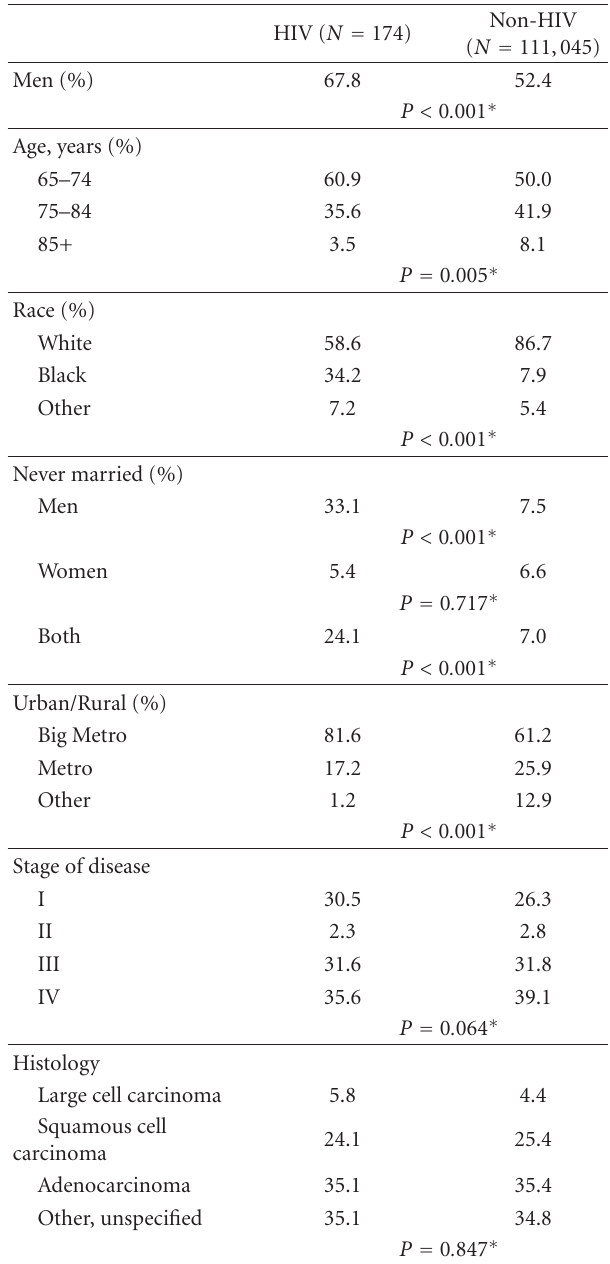
Table 1: Demographic characteristics of NSCLC cases based on HIV infection